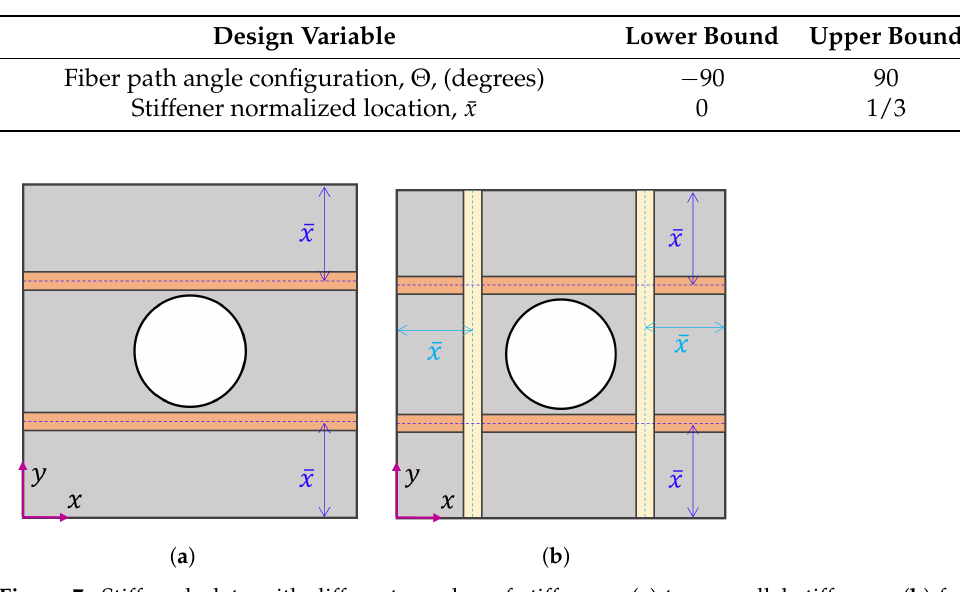
Figure 7. Stiffened plate with different number of stiffeners. ( a ) two parallel stiffeners; ( b ) four orthogonal